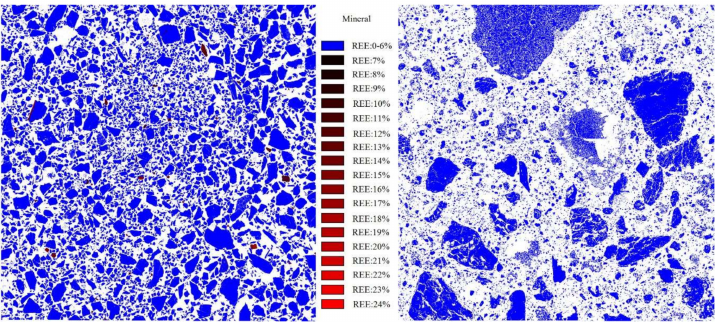
Figure 18. REE elemental mapping of eudialyte concentrate and leach residue by